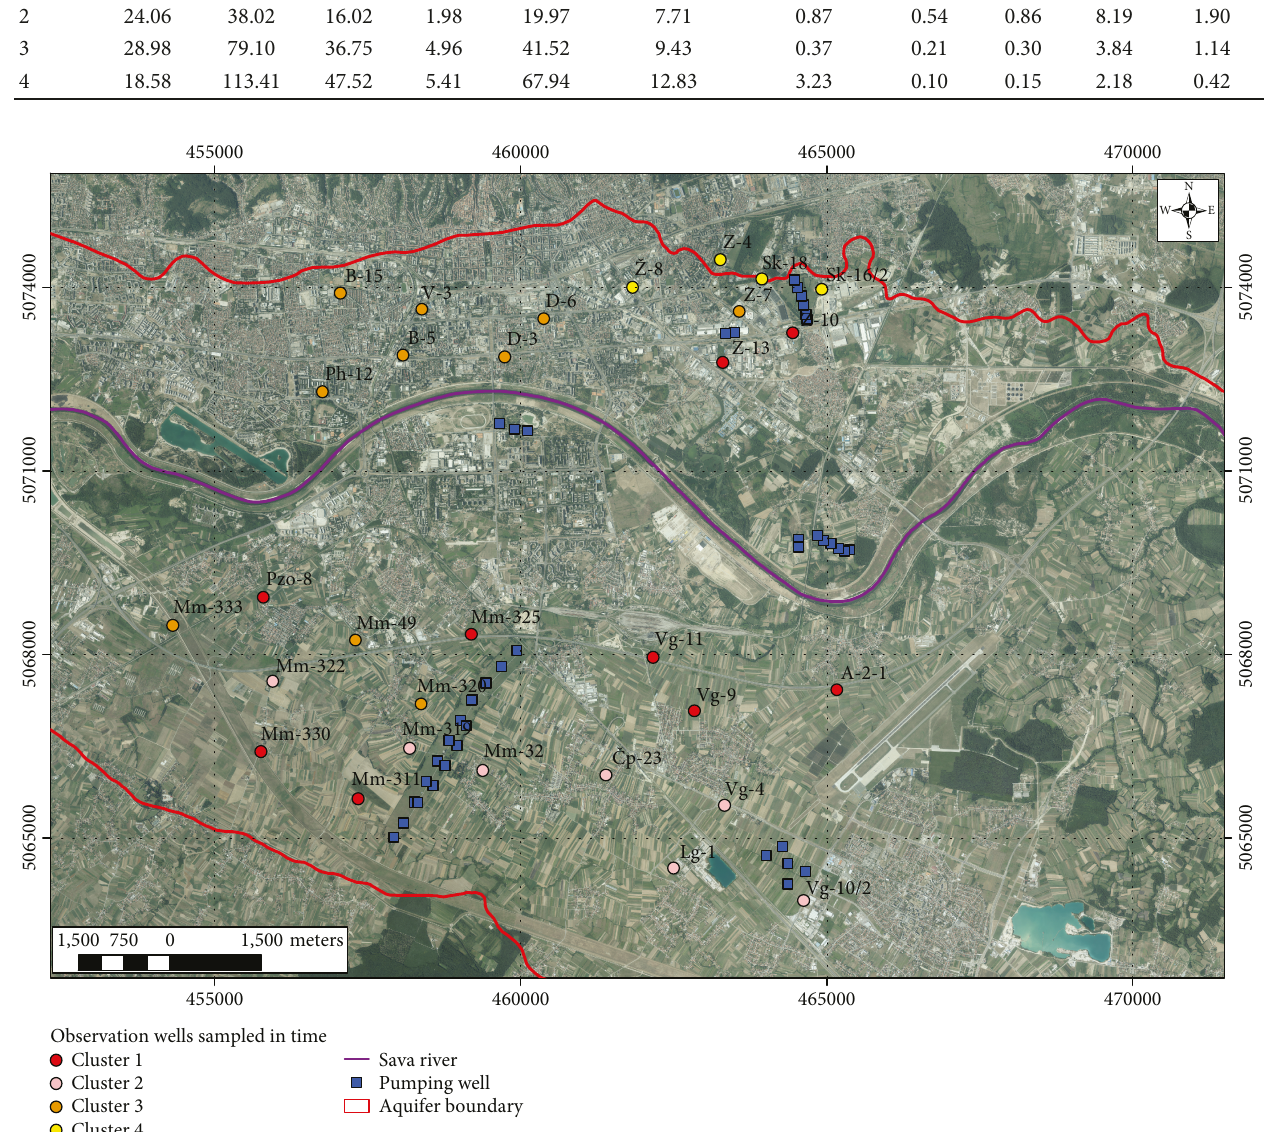
Figure 8: Locations of observation wells distributed within the cluster